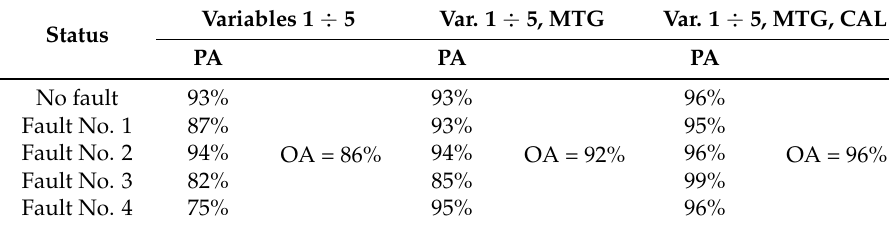
Table 3. OA and PA obtained by the hybrid FDI system when the five monitored variables of Table 1 are used, when the maximum temperature gradient (MTG) inside the SOFC stack is added, and when the cathodic activation losses (CAL) inside the SOFC stack are additionally